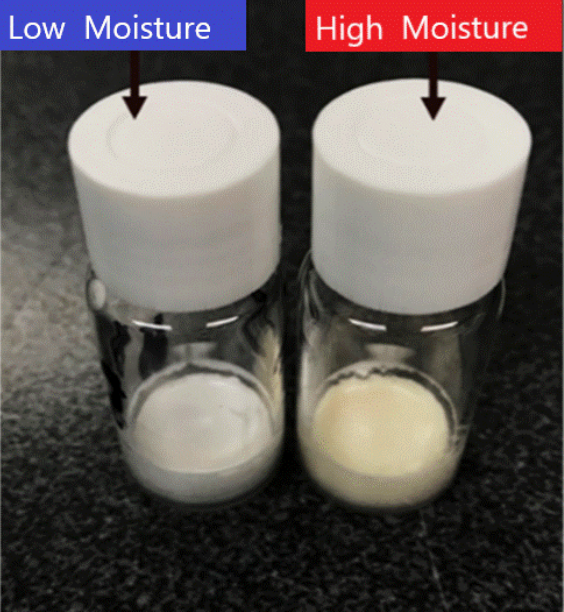
Figure 11. Comparison of the visual appearance between vials FD in either “low” or “high” moisture cycles for FD IgG (50 mg/mL) after 12 months storage at 45 °C.